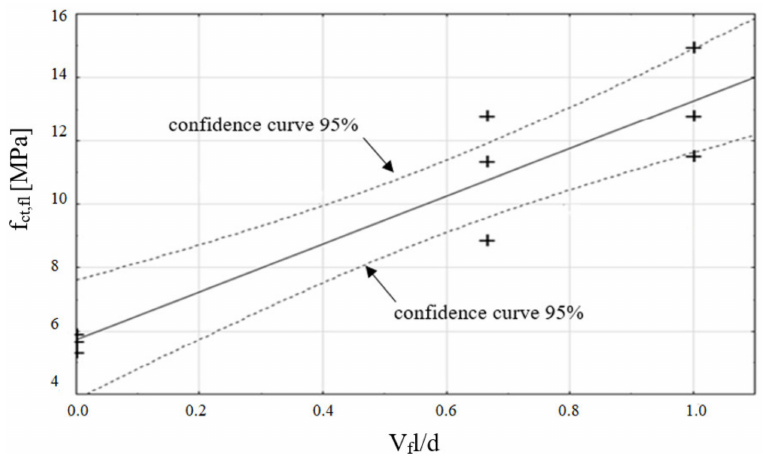
Figure 4. Flexural tensile strength results (f ct,fl ), depending on the fibre reinforcement ratio (V f l / d), the regression curve, and 95% confidence curves.